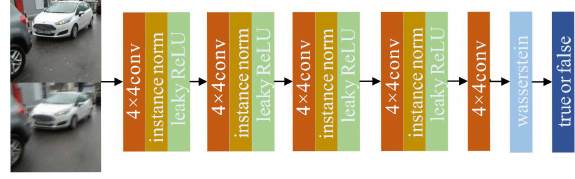
Fig. 4. Discriminator network